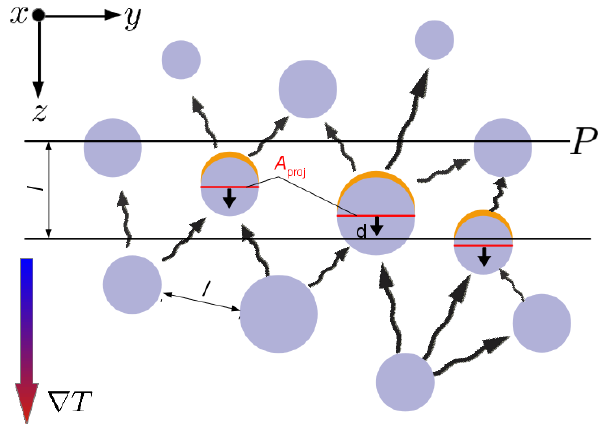
Fig. 2. Simplified geometry to illustrate the estimation of vapor flux from the apparent movement of the structure. The wiggly arrows show the schematic vapor flux, orange caps indicate the locations of sublimation. The reference area A proj is used for the derivation using the Wigner-Seitz radius. The displacement vector d , the eval- uated slice P and the structural length l are also schematically in- dicated. The temperature gradient is pointing along the z -axis, cor- responding to higher temperatures at the bottom. This definition of the coordinate system, with the x -axis pointing into the paper plane, is used throughout this